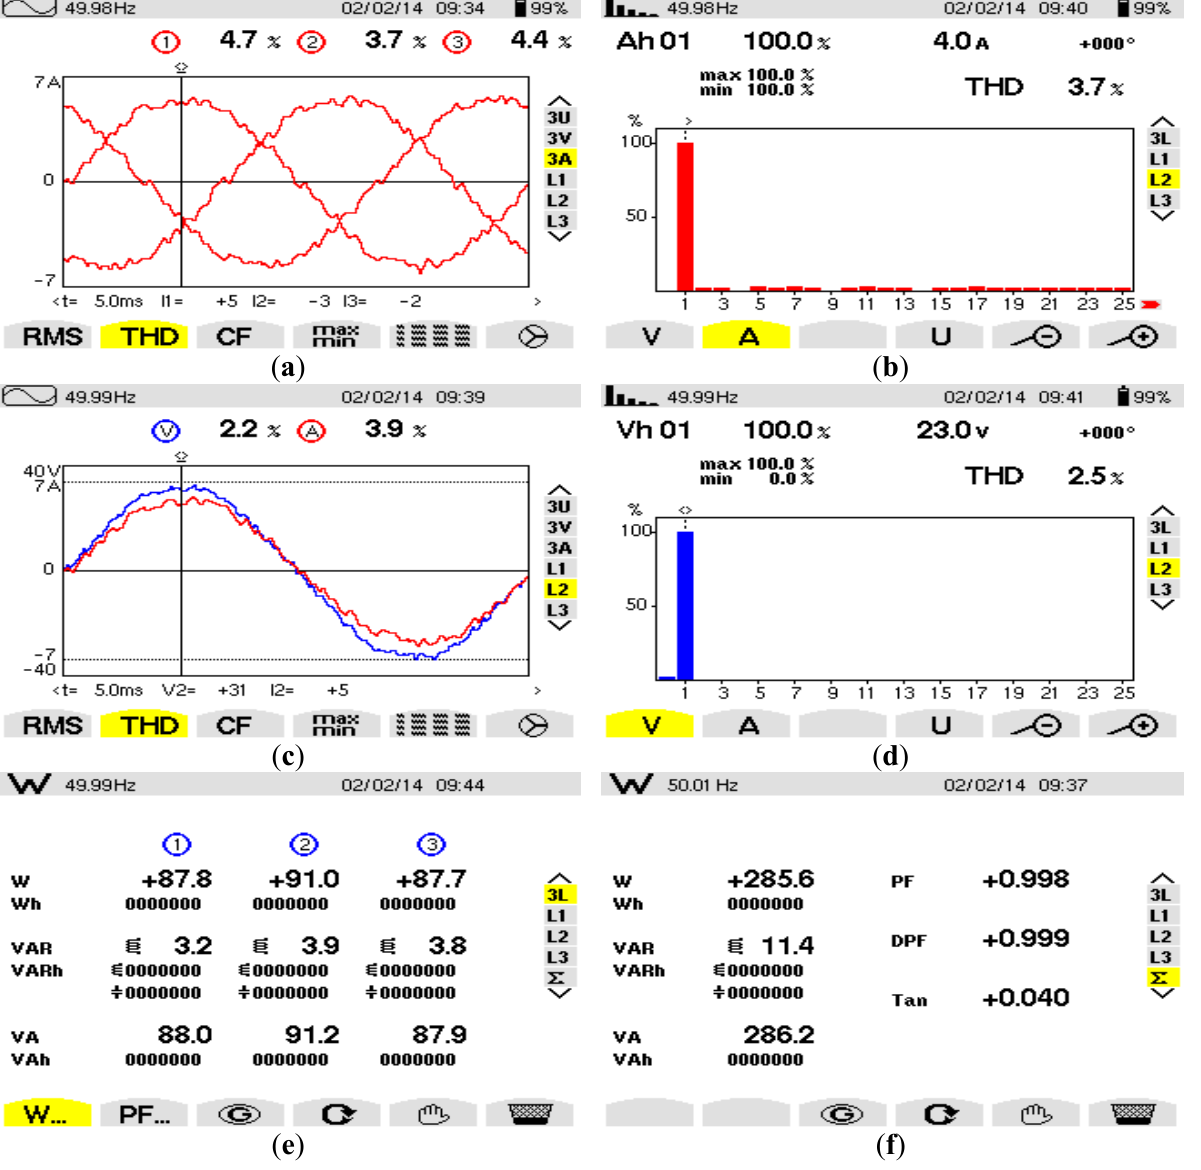
Figure 17. Experimental results for balanced sinusoidal grid voltage: ( a ) three-phase line currents with their THD; ( b ) frequency spectrum of line current, phase-b; ( c ) line voltage and current, phase-b; ( d ) frequency spectrum of line voltage, phase-b; ( e ) power balance after filtering; ( f ) characteristic and power balance sheet of the grid after